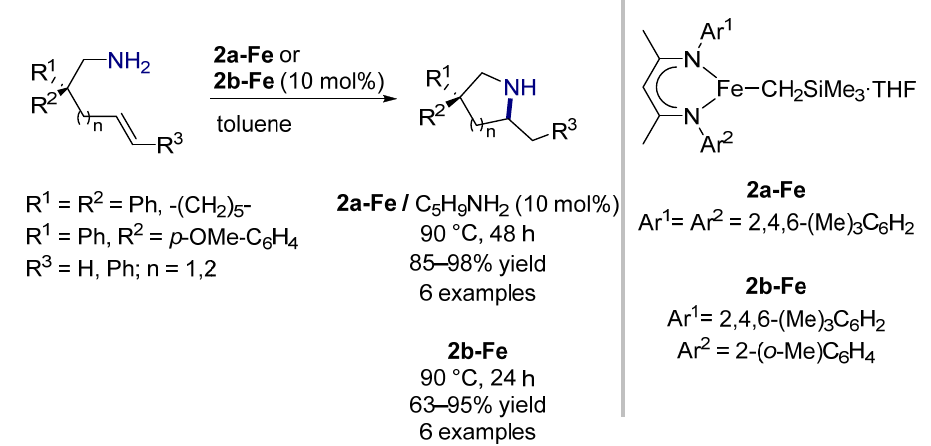
Figure 7. Cyclohydroamination of primary amines tethered to unactivated alkenes catalyzed by well-defined β -diketiminatoiron(II) alkyl complexes.